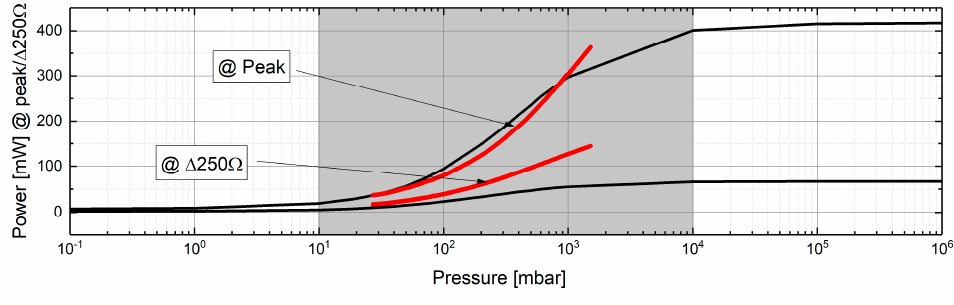
Figure 4. Modelled and measured gauge response at selected